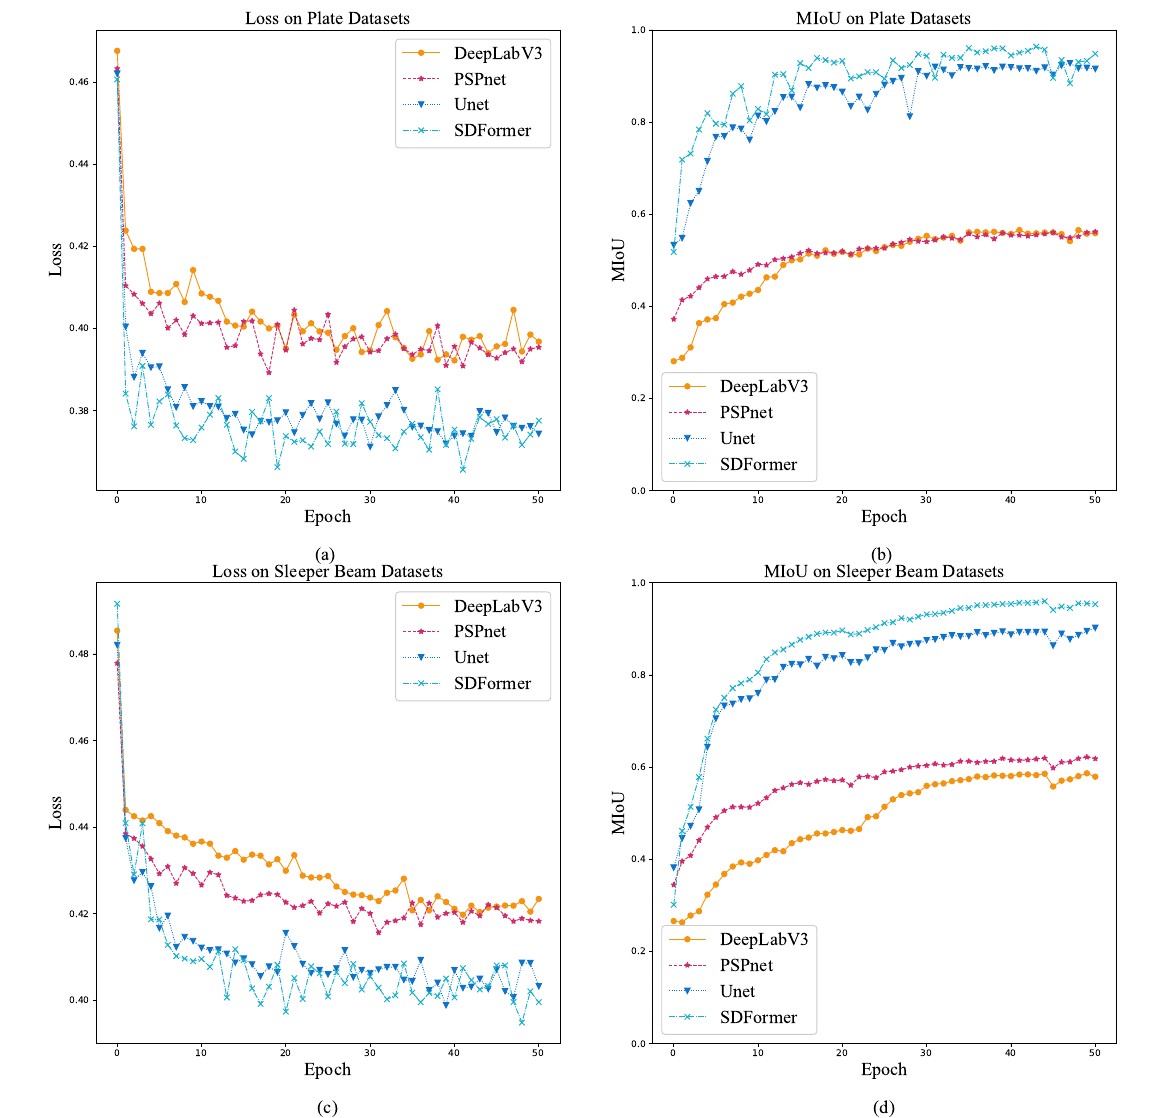
Figure 9. Training loss curve and MIoU curve. ( a ) Training loss curve on plate dataset. ( b ) Training MIoU curve on plate dataset. ( c ) Training loss curve on sleeper beam dataset. ( d ) Training MIoU curve on sleeper beam